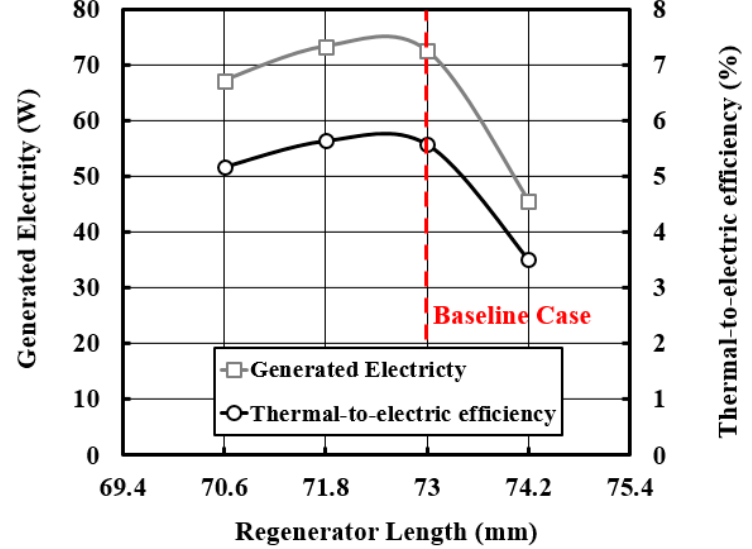
Figure 11. Generated electricity and thermal-to-electric e ffi ciency versus the regenerator length.